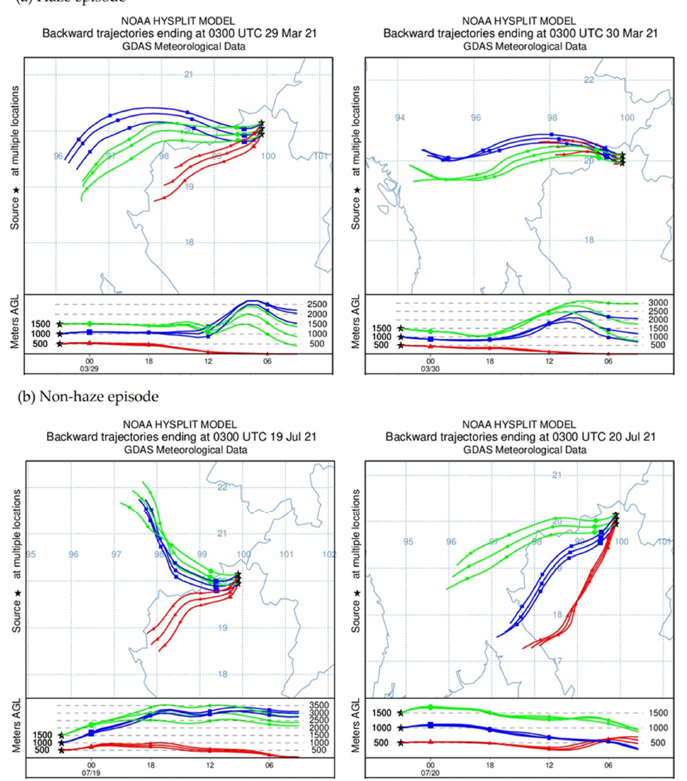
Figure 3. Backward trajectories result for PM 2.5 monitoring in haze episode and non-haze episode.